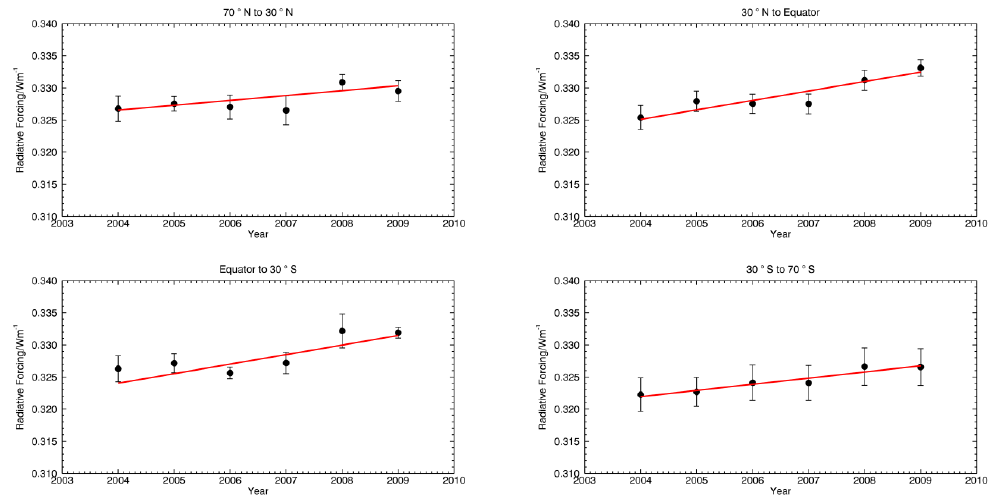
Fig. 5. The trends in the radiative efficiency-weighted total fluorine mean between 2004 and 2009. The red line represents the line of best fit for the radiative efficiency-weighted mean volume mixing ratio (the black circles). The error bars shown in the plots are the standard deviation of the data used to calculate the means.